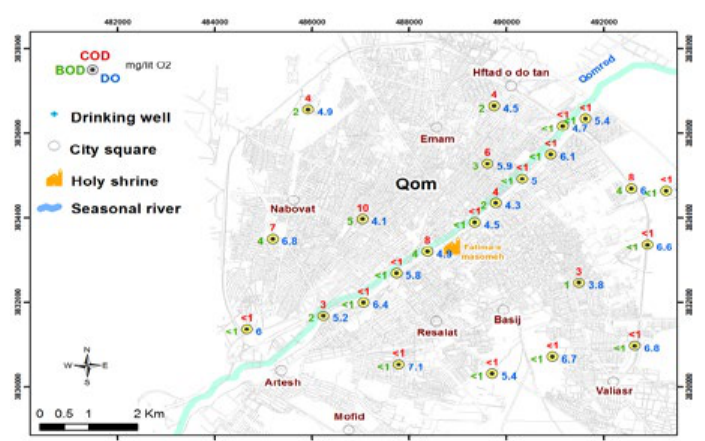
Fig. 4: DO, BOD and COD concentration of groundwater in Qom urban areas Fig. 3. Groundwater turbidity in Qom urban areas.